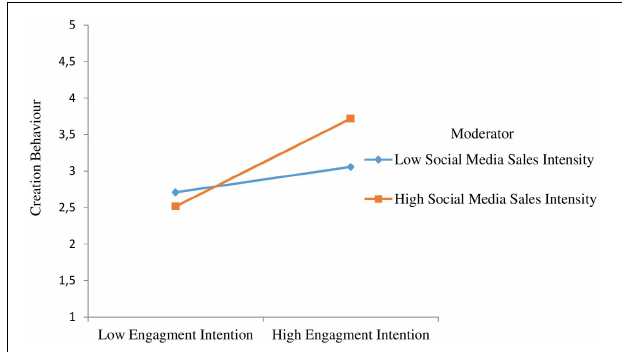
FIGURE 5 | Interactive effects of engagement intention and social media sales intensity on